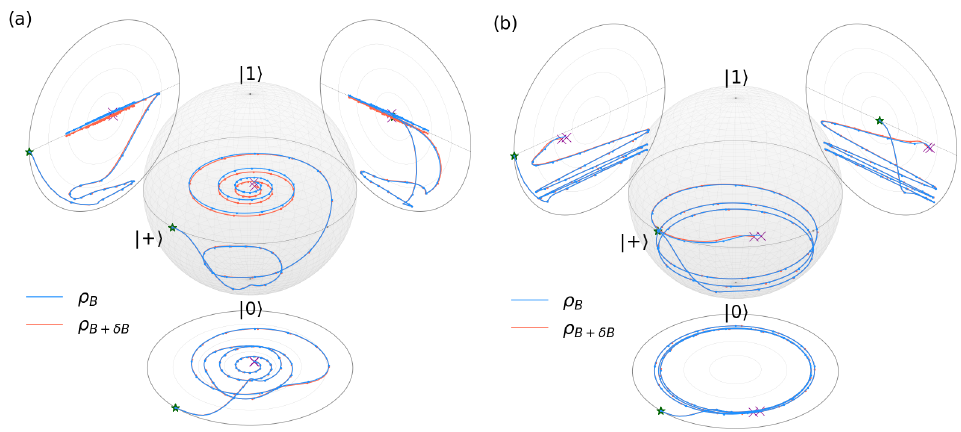
Figure 2: Controlled dynamics of the states ρ qubit Bloch sphere, for (a) parallel dephasing, subjected to the control fields shown in Fig. 1(b), and (b) relaxation, subjected to the control fields shown in Fig. 3(b). The green star and pink cross indicate the start and end of the evolution respectively. The density of dots reflects the speed of the evolution, with a low density indicating high